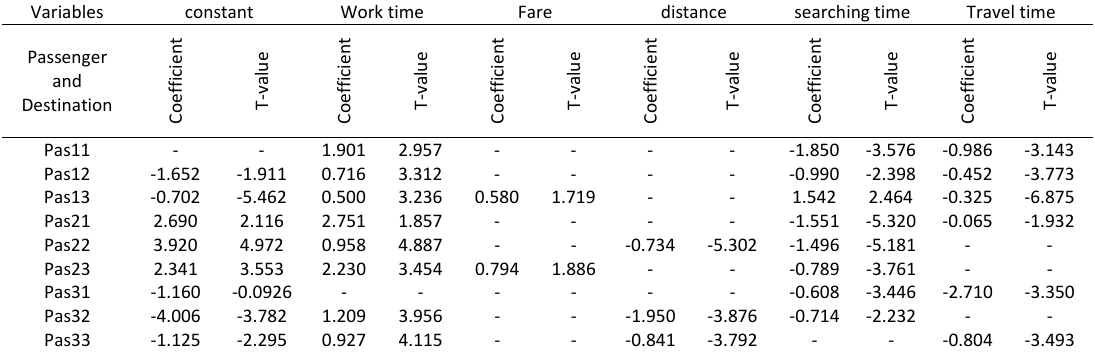
Table 4.Result of simultaneous nested logit model Table 4. Result of simultaneous nested logit model